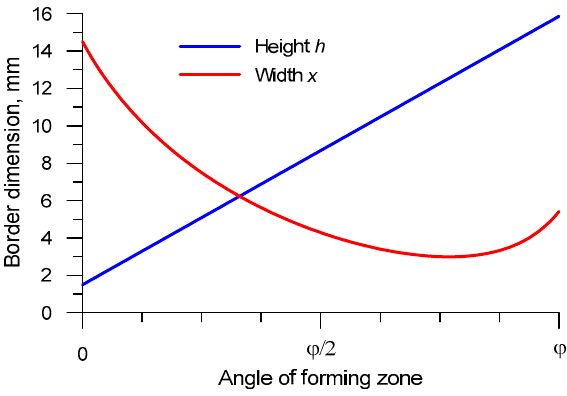
Figure 6. Roll collar parameters versus forming zone angle.